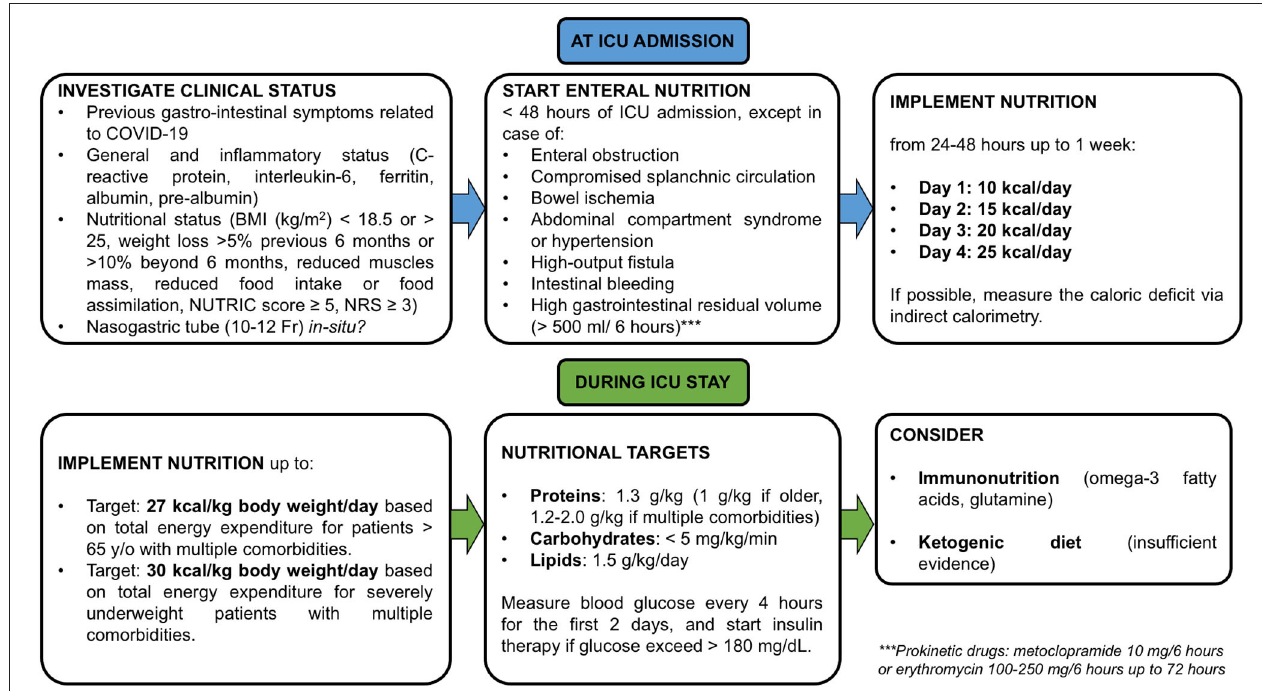
FIGURE 3 | Dietetic recommendations in cases of COVID-19 with ARDS. Nutritional recommendations for critically ill patients with COVID-19 and ARDS from ICU admission to ICU stay. NRS, nutritional risk screening. Each nutritional support is suggested to be calculated on Ideal body